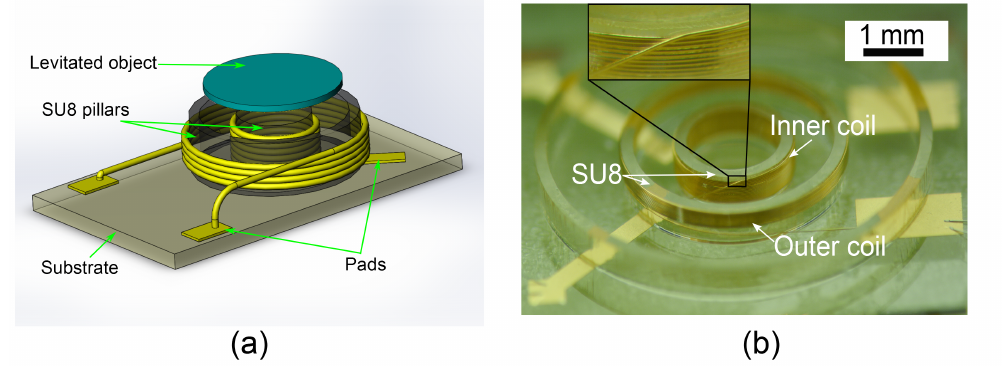
Figure 1. ( a ) Schematic of a 3D micromachined inductive suspension (MIS); ( b ) closeup of a 3D MIS without the proof mass